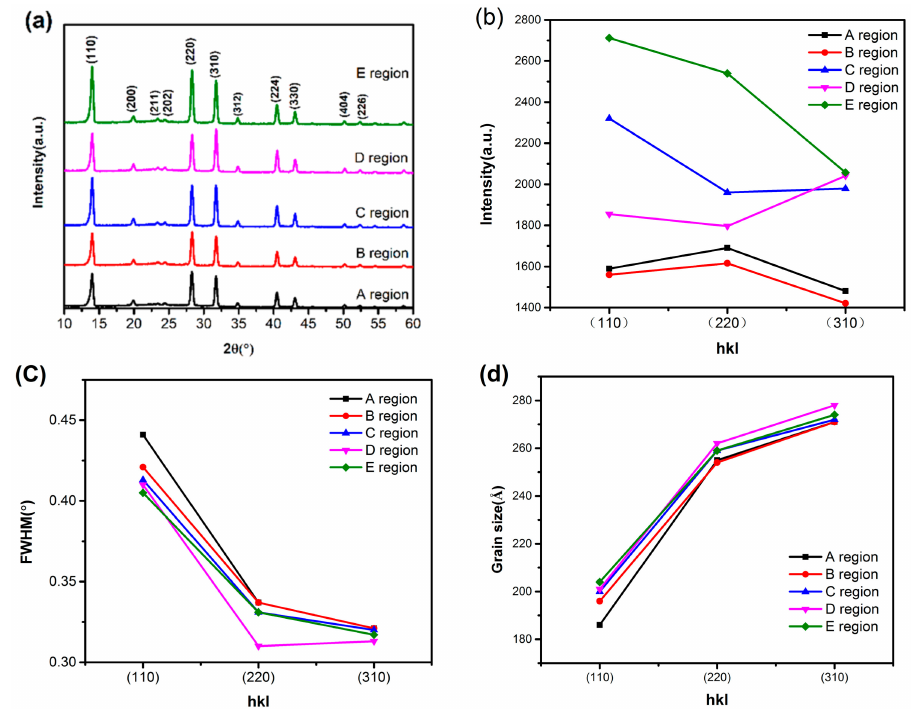
Figure 3. ( a ) XRD patterns of the large-area MAPbI 3 films prepared by single-source thermal evaporation, ( b ) the typical peak intensities change patterns, ( c ) the FWHM change patterns, and ( d ) the grain size change